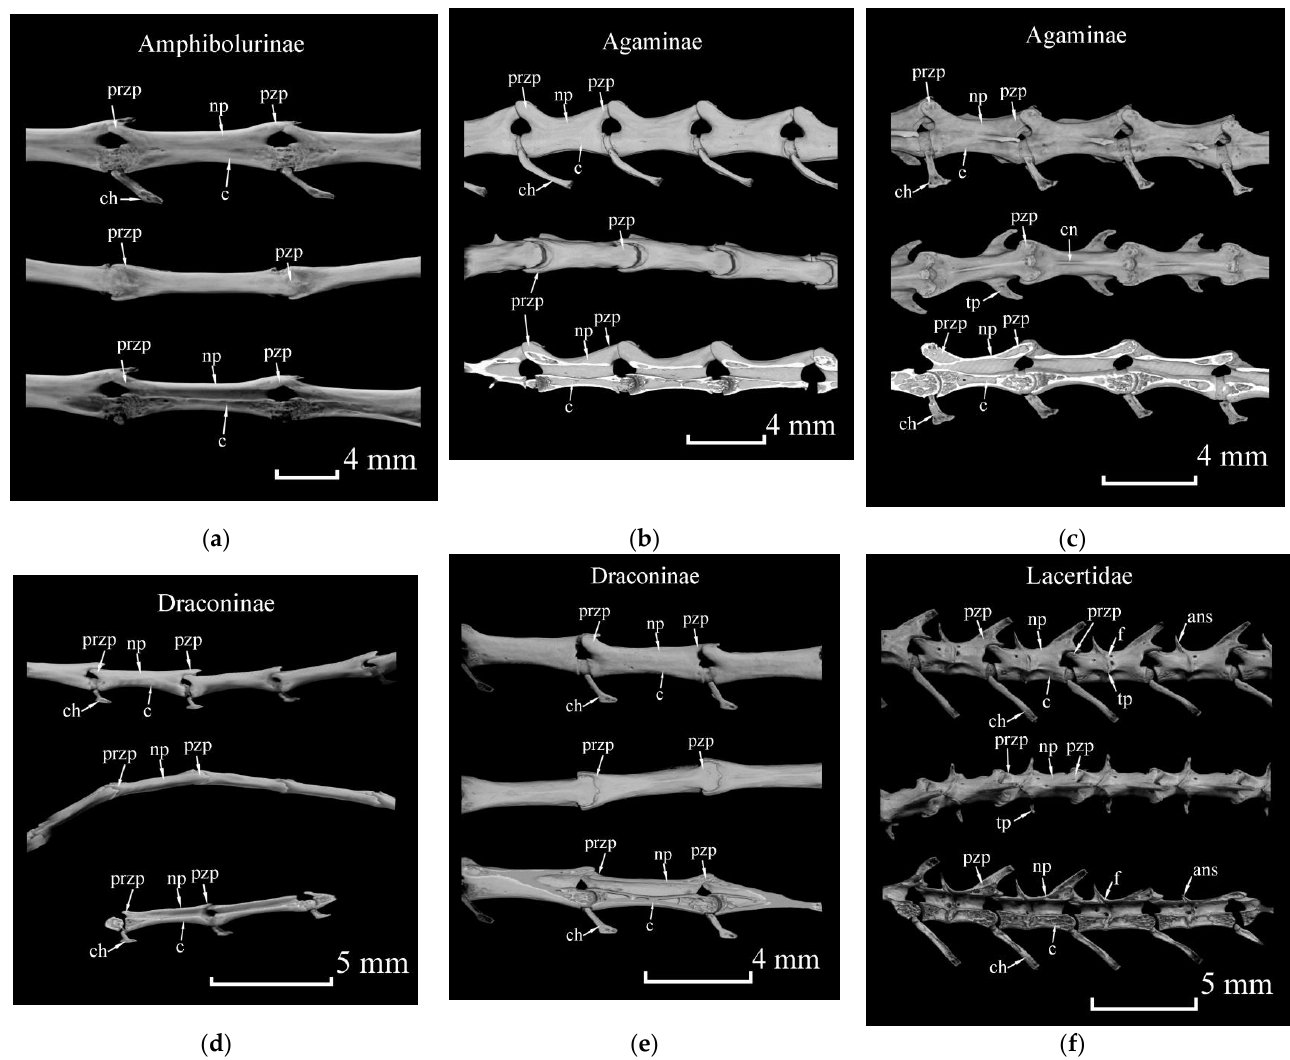
Figure 1. Micro-CT of intact tails of three subfamilies of agamids (with pseudoautotomy or no autotomy) and lacertids (autotomy) with different combinations of caudal autotomy and regeneration. The figure shows (from top to bottom): sagittal plane, frontal plane, a sagittal slice through the middle of the vertebra; ( a ) intact part of tail of Intellagama lesueurii (Australia, ZISP 20474), capable of pseudoautotomy and regeneration; ( b ) intact part of tail of Paralaudakia caucasia (Russia, ZISP 31550), capable of pseudoautotomy and regeneration; ( c ) intact part of tail of Trapelus sanguinolentus (Kazakhstan, ZISP 31548), no autotomy; ( d ) intact part of tail of Mantheyus phuwuanensis (Laos, ZISP 30558), capable of pseudoautotomy and regeneration; ( e ) intact part of tail of Calotes versicolor (Ceylon (Sri Lanka), ZISP 14261), probably capable of pseudoautotomy without regeneration; ( f ) intact part of tail of Lacerta agilis (Russia, ZISP 31549), capable of intravertebral autotomy and regeneration. ans—anterior neural spine; c—centrum; ch—chevron (hemapophysis); cn—crista neurapophysis, neurapophysis crest; np—neurapophysis; przp - prezygapophysis; pzp—postzygapophysis; tp—transverse processes.